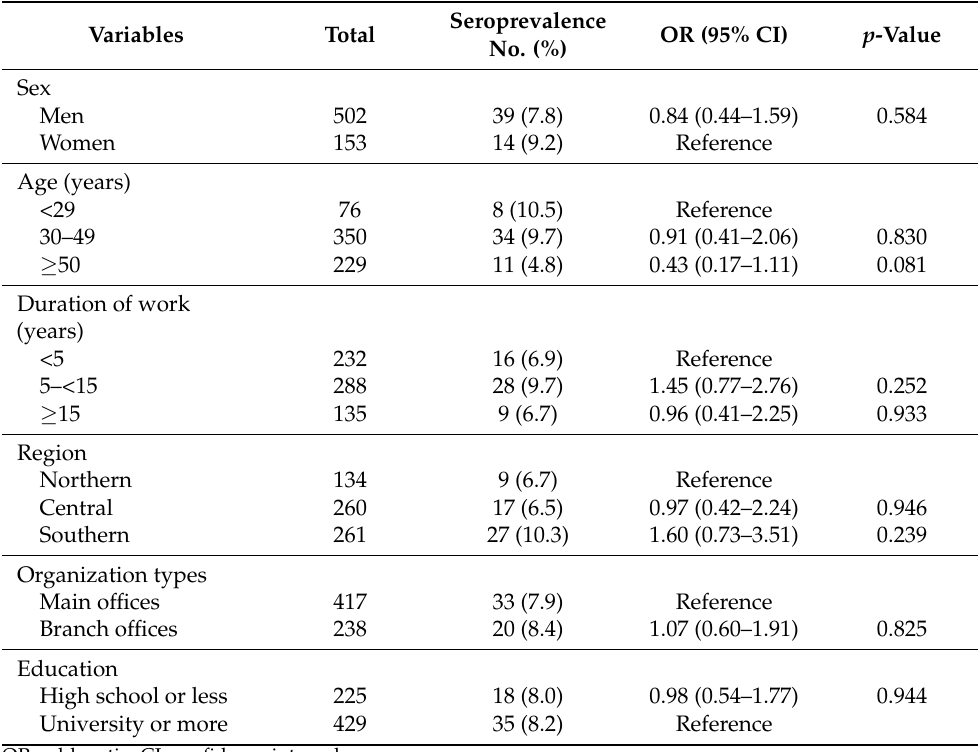
Table 2. Univariate logistic regression analysis between demographic characteristics and Lyme disease seroprevalence among National Park Office forestry workers in South Korea.